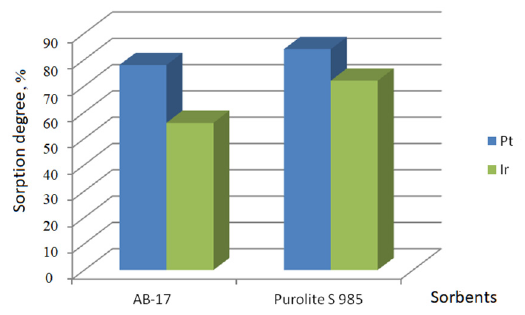
Figure 5. PGM comparative sorption using anionites AB-17-8 and Purolite S985 from sulfate-chloride solutions. Solution composition, g/L: 25 NaCl, 25 HCl, 25 Н 2 SO 4 , 3.4 Fe, 1.2 g/L Mg, 5.6 mg/L Pt, 1.2 mg/L Ir. Sorbent consumption of 2 g/L.